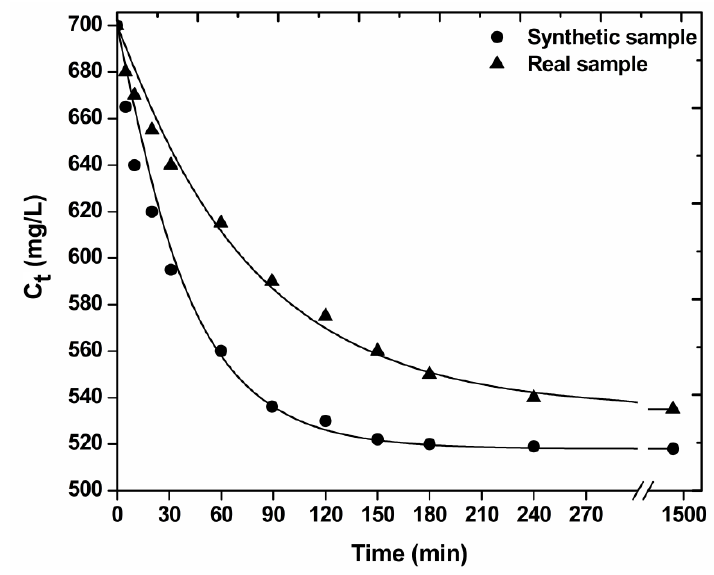
Figure 5. Effect of contact time on decolorization of real and synthetic dyeing solutions with COF (pH = free, 700 mg/L total dye concentration; 1 g/L adsorbent; T = 25 °C; 140 rpm; 5 min–24 h